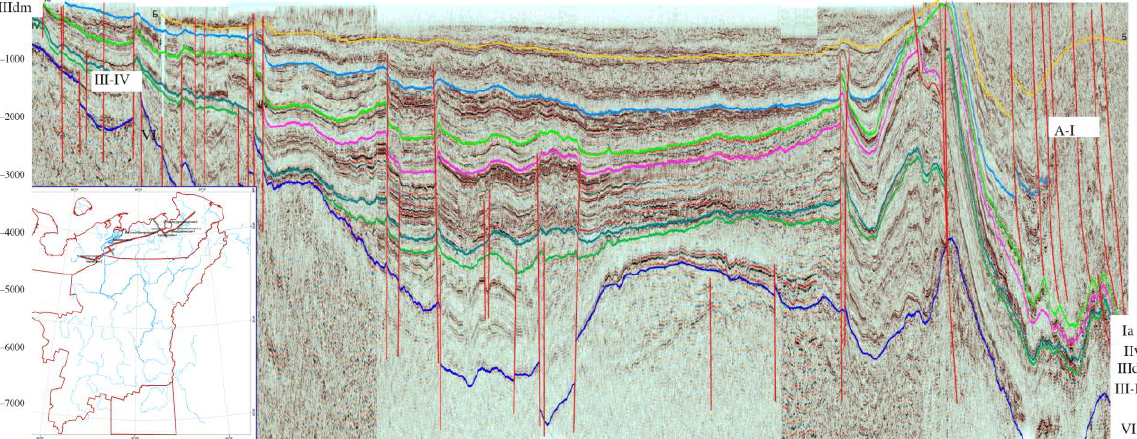
Figure 10. Composite seismic section through the main tectonic zones of the North of the Timan-Pechora sedimentary basin, after [41].